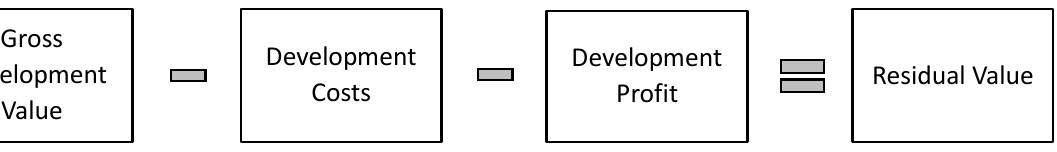
Figure 1: Basic calculation of the residual value (source: